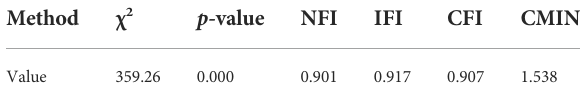
TABLE 4 Results of Fit Test (Source: authors ’